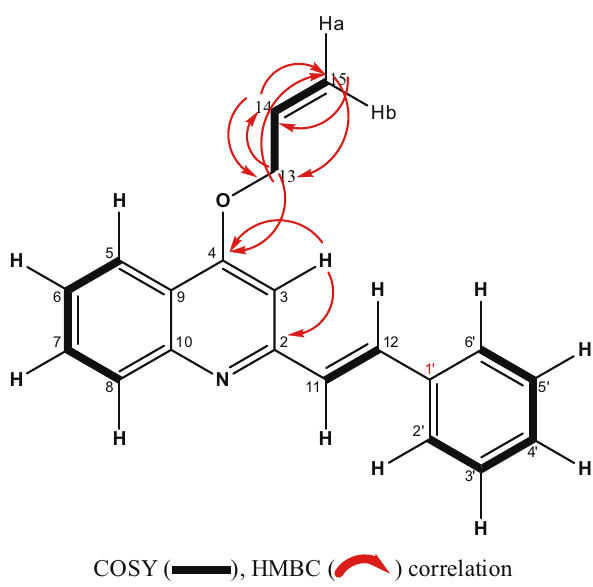
Figure 10: Structure elucidation of compound 2h